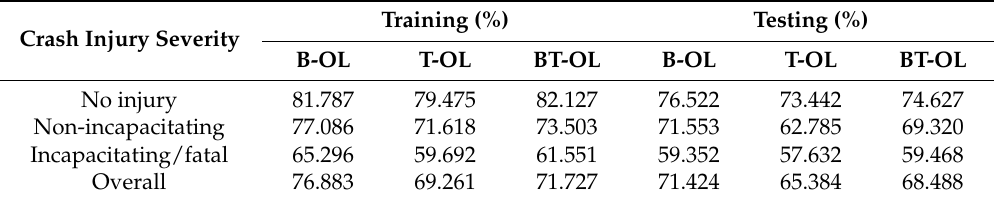
Table 8. Prediction accuracy of OL model in the training and testing.